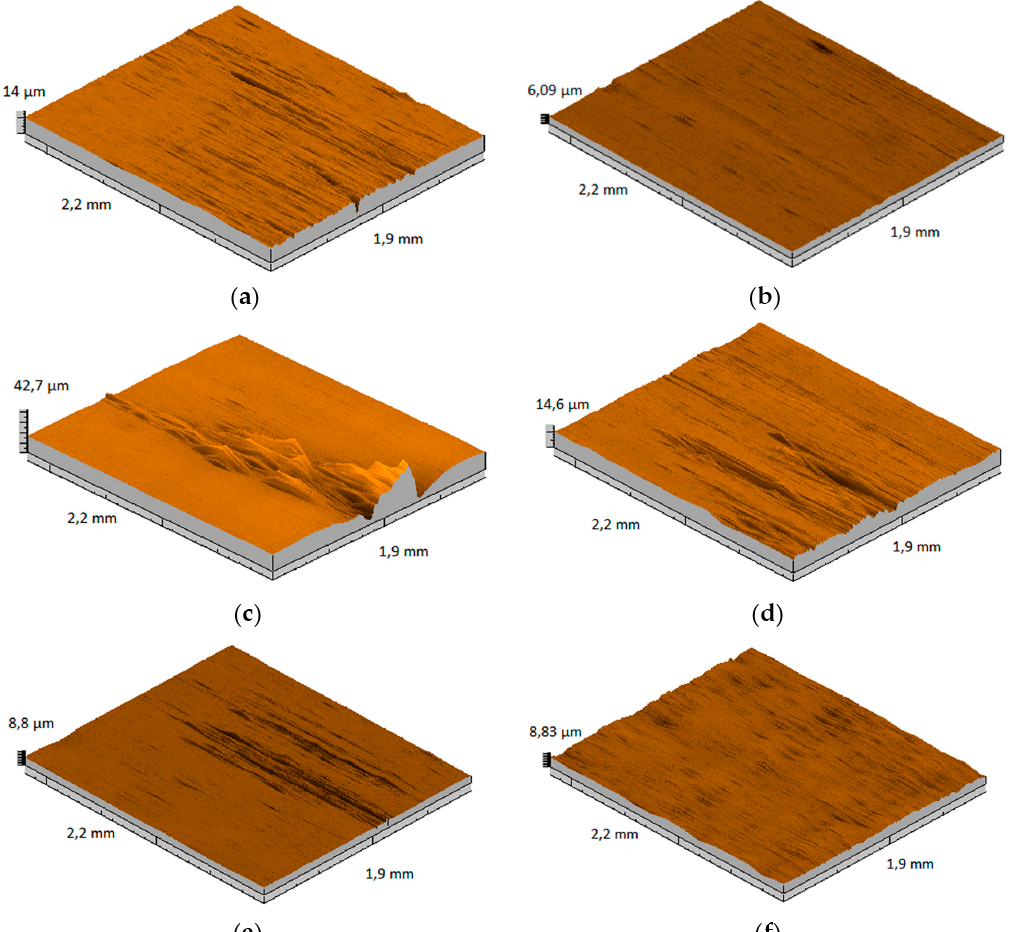
Figure 8. Surface portrayal of one primary crown per series after the end of the test: ( a ) series A; ( b ) series B; ( c ) series C; ( d ) series D; ( e ) series E, and ( f ) series F. These selected examples correspond